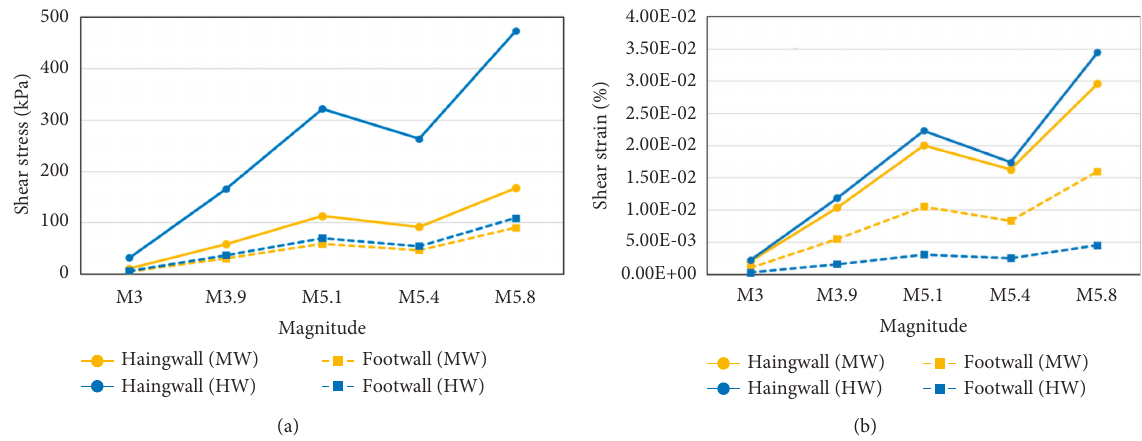
Figure 15: Comparison of the shear stress and shear strain between the hanging wall and foot wall in M.W. rock and H.W. rock. The shear stress and shear strain of hanging wall are larger than those of footwall. (a) Shear stress. (b) Shear